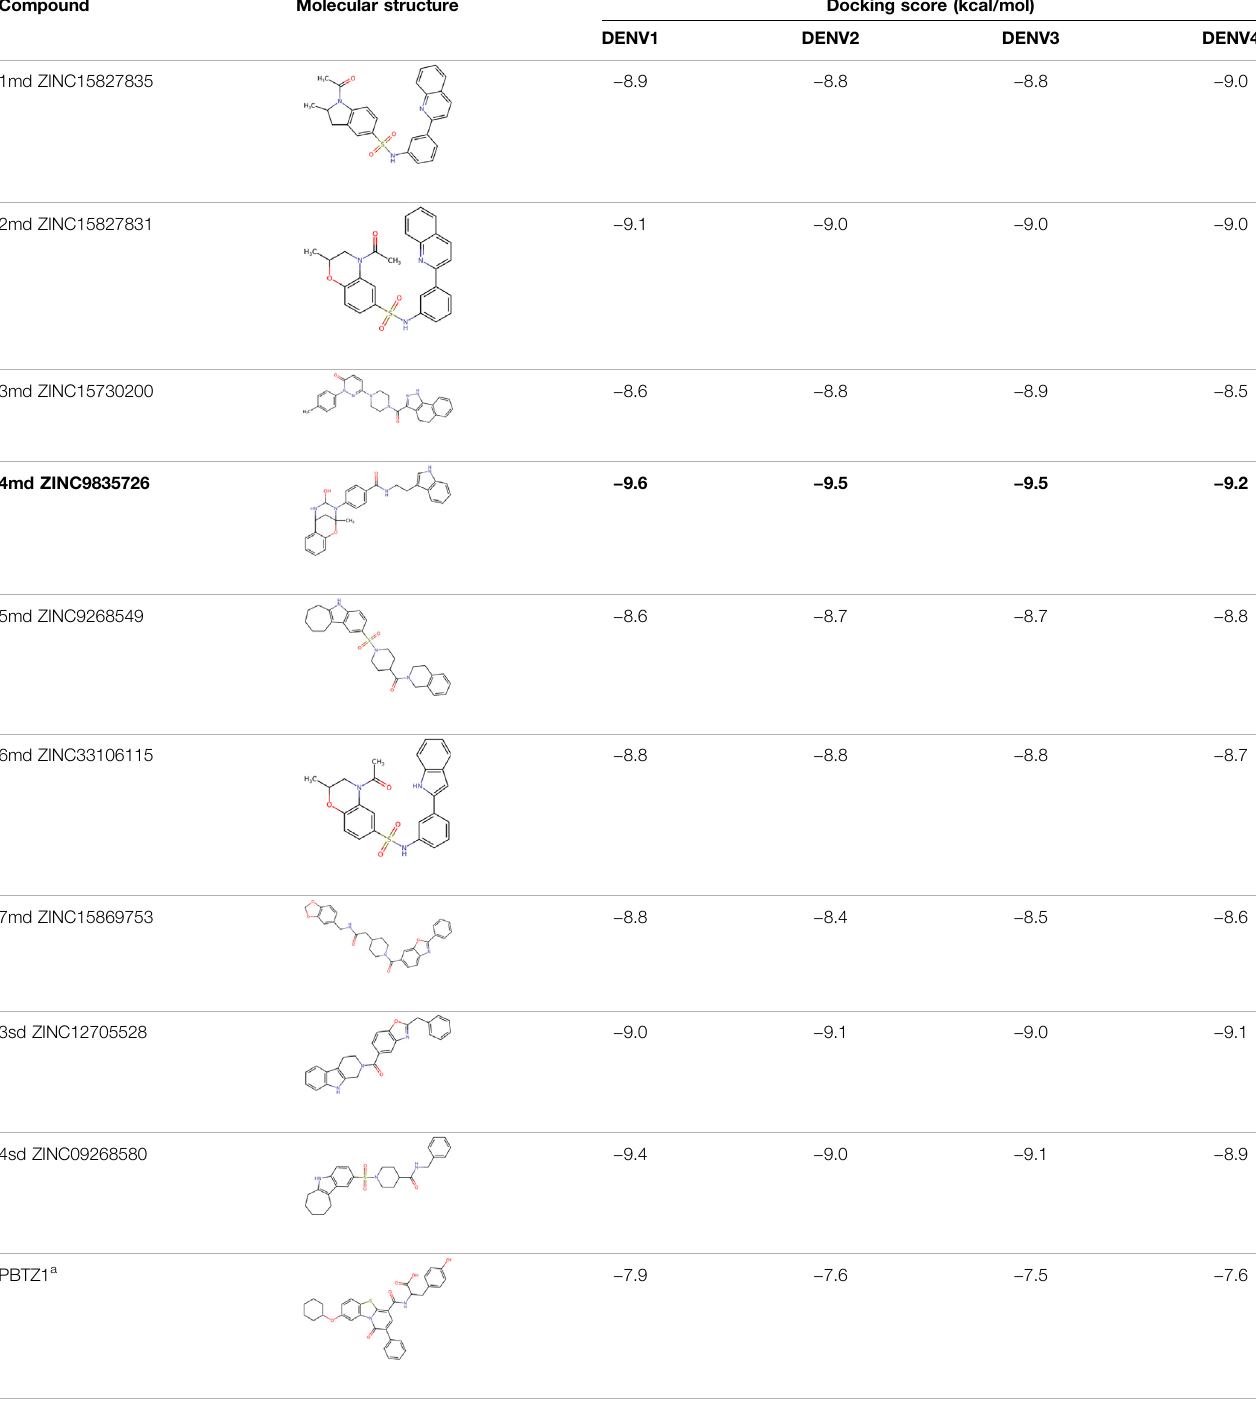
a Crystal control: compound with reported anti-dengue activity and with possible binding mode in cavity B (Cannalire et al., 2020).